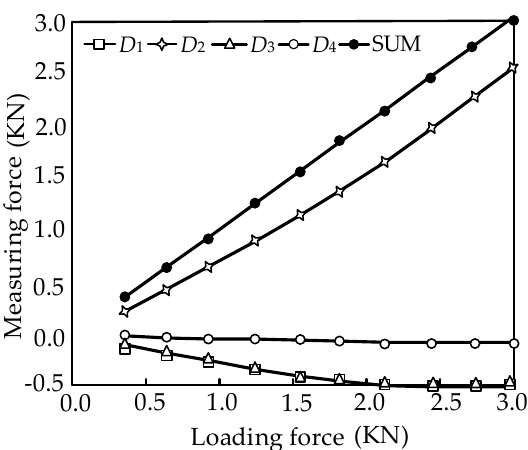
Figure 23. Calibration on the second branch.